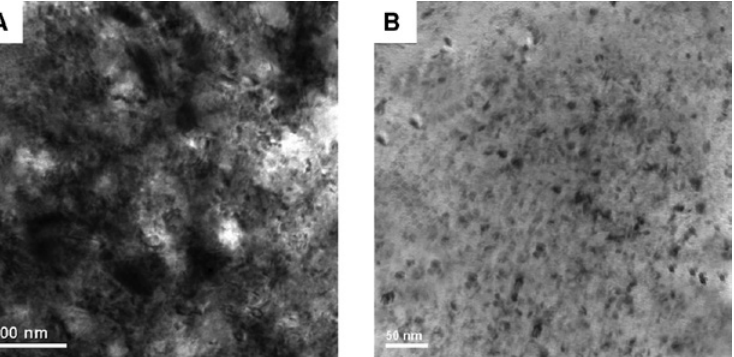
Figure 4: Transmission electron microscopy (TEM) micrographs of Ni-TiN composite coatings deposited with different magnetic intensities: (A) 0 T and (B) 0.3